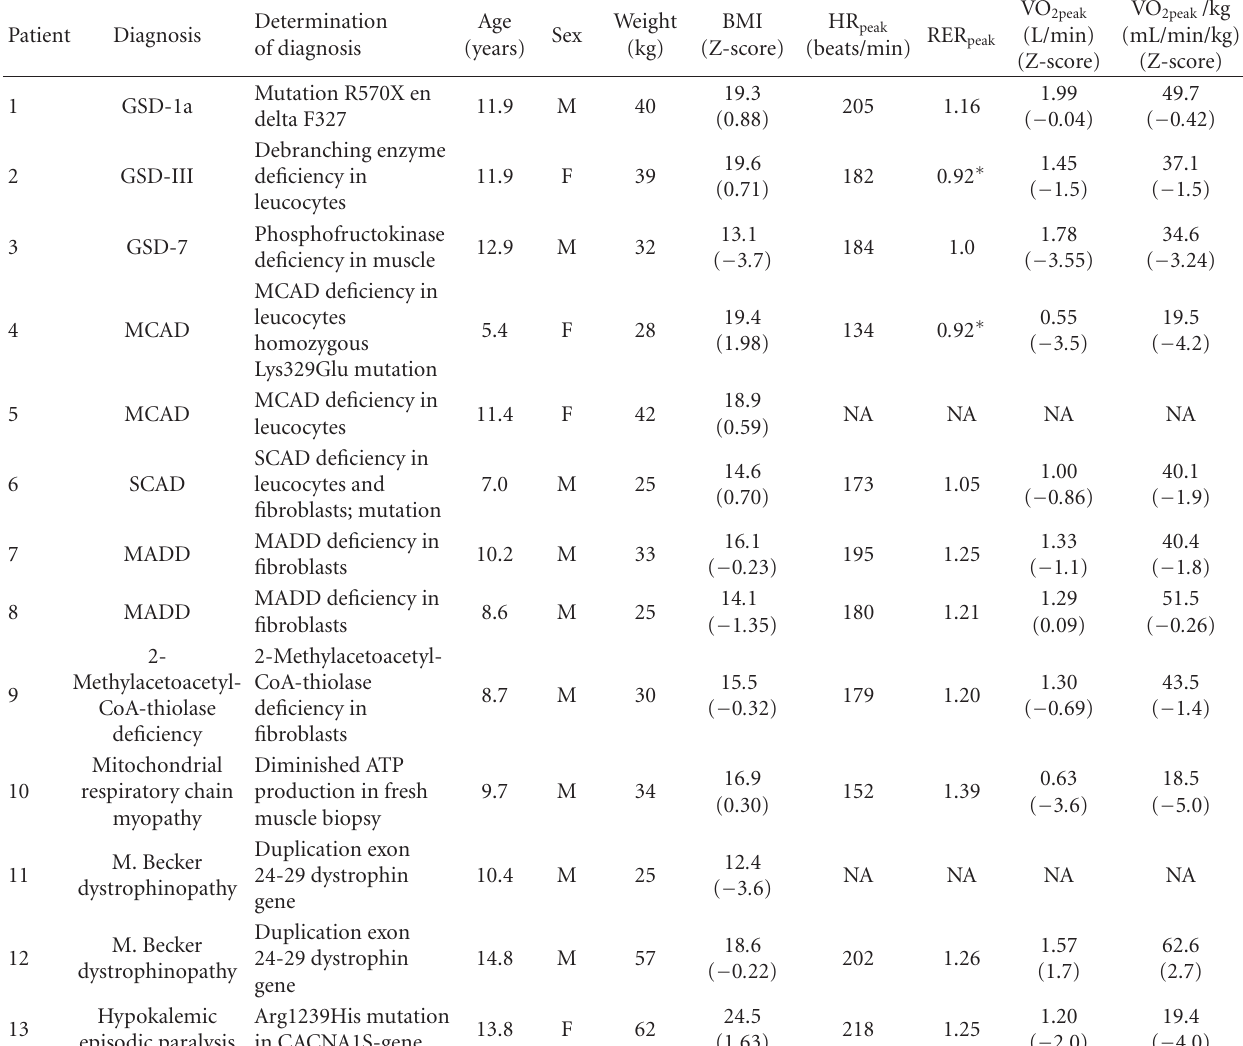
Table 1: Cardiopulmonary measurements of patients during the